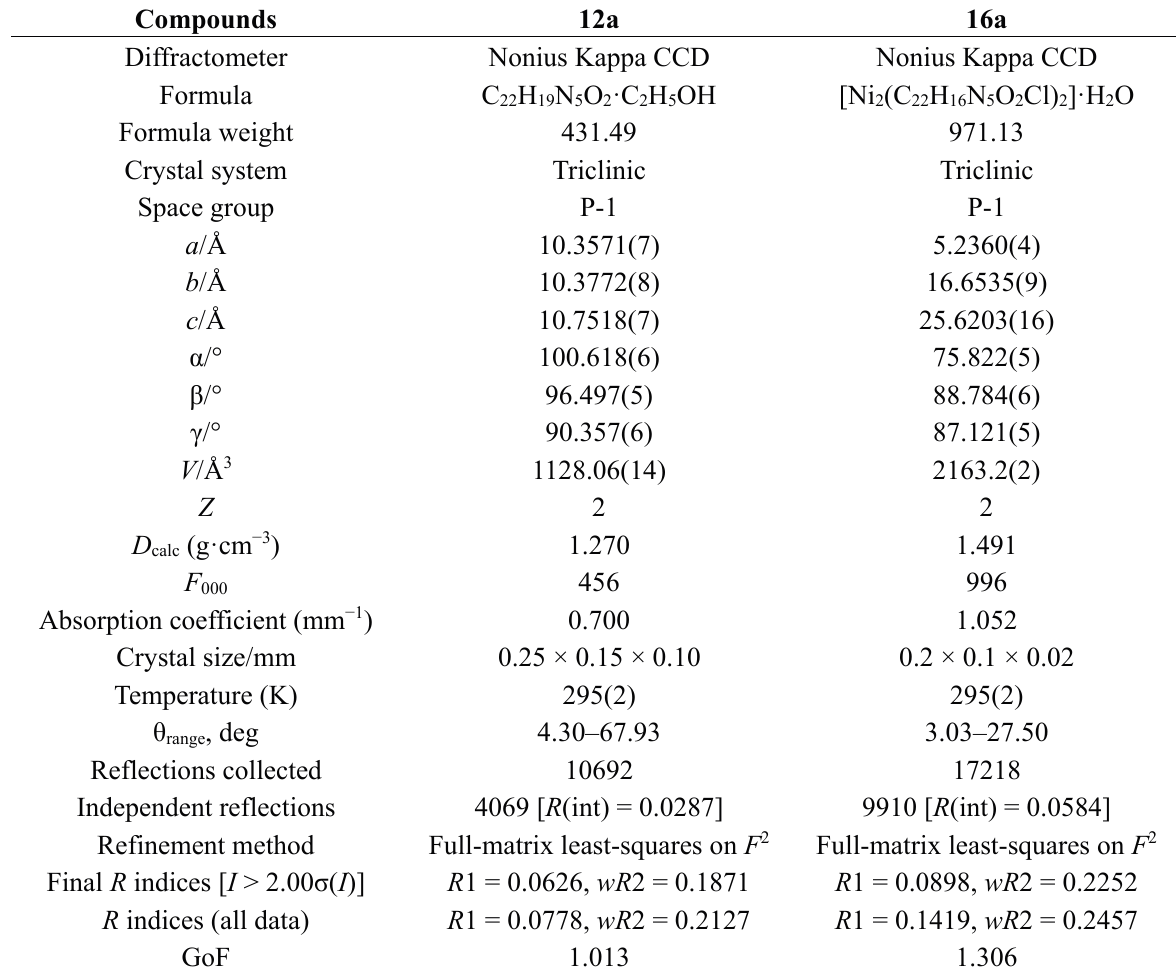
Table 2. Crystal data of semicarbazone 12a and complex 16a